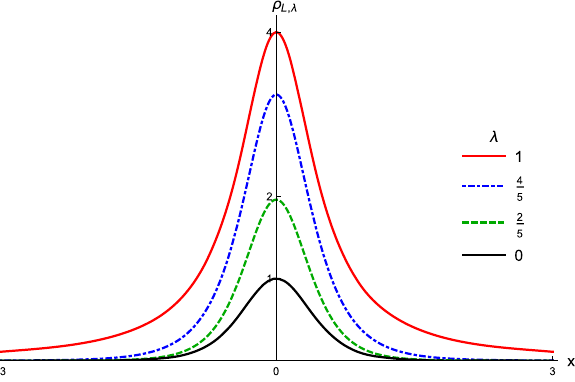
Fig. 4 The energy density (31) for some values of λ . Here one notes how ρ L ,λ behaves as λ → 1, becoming more diffuse but keeping its localized